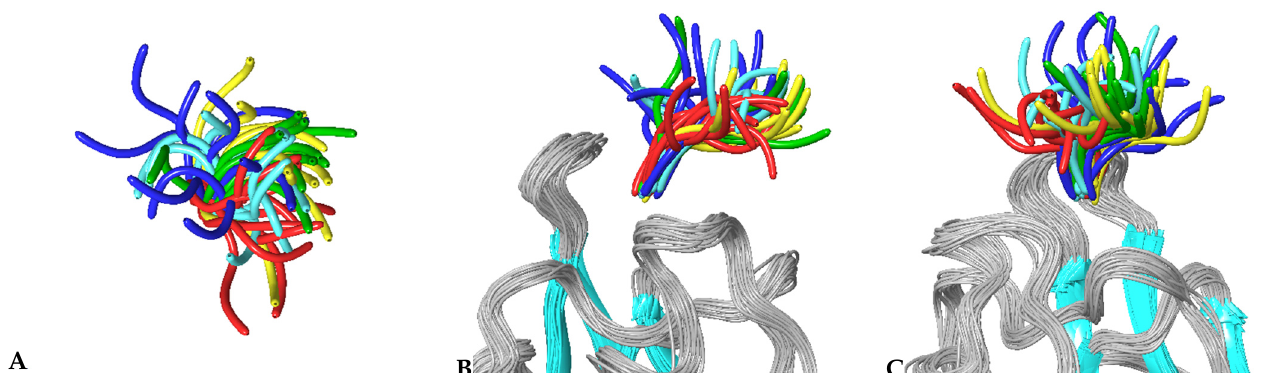
Figure 4. Sampled conformational space of NRP1-peptide complexes. Representative structures of the ten most populated clusters obtained from two repeats of 30 ns molecular dynamics simulations were ovelayed for each complex, ( A ) top view, ( B ) side view that corresponds to the orientation of the top view and ( C ) side view rotated by 90°. NRP1 is shown as ribbons with beta strands coloured blue and loops coloured grey. Peptides are denoted by using single colours: C—cyan; B167—blue; B186—yellow; A165—green and control red.